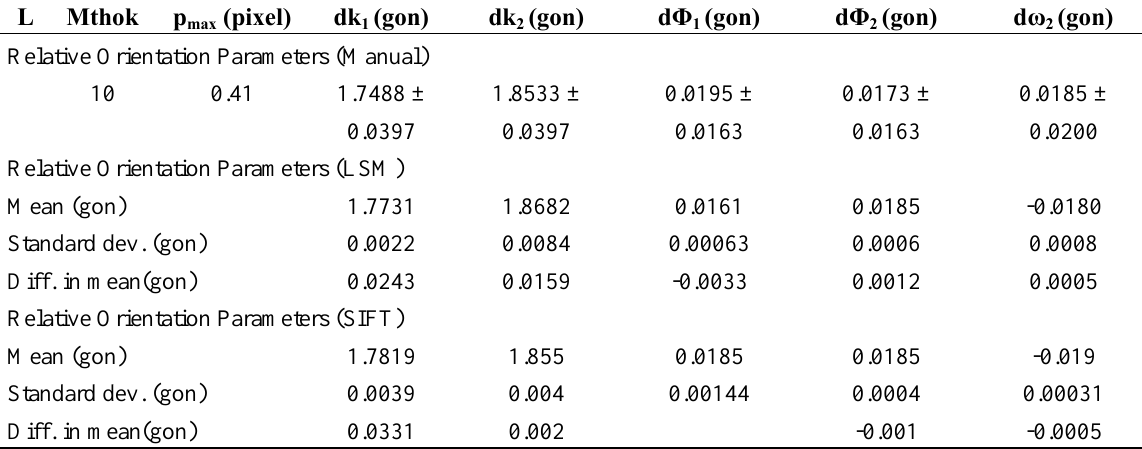
Table 2. The relative orientation parameters performed through manual and automatique techniques and their statistical